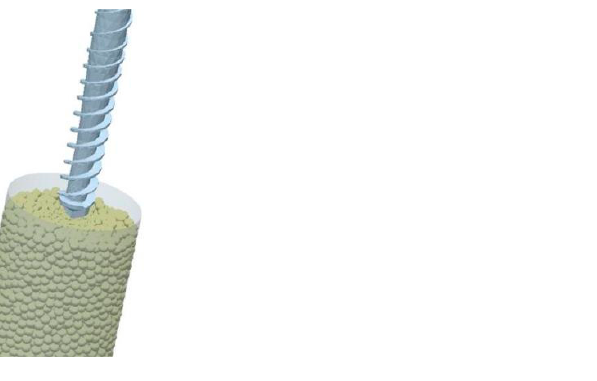
Figure 2. Discrete element simulation model drilling simulated lunar soil.